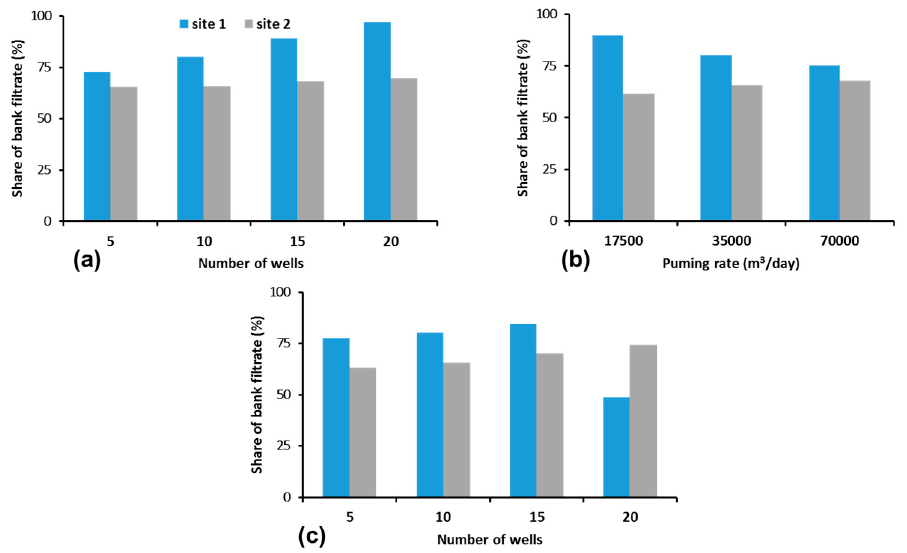
Figure 5. E ff ect of number of wells and pumping rate on bank-filtrate share (BF %): ( a ) Scenario 1, ( b ) Scenario 2, and ( c ) Scenario 3.